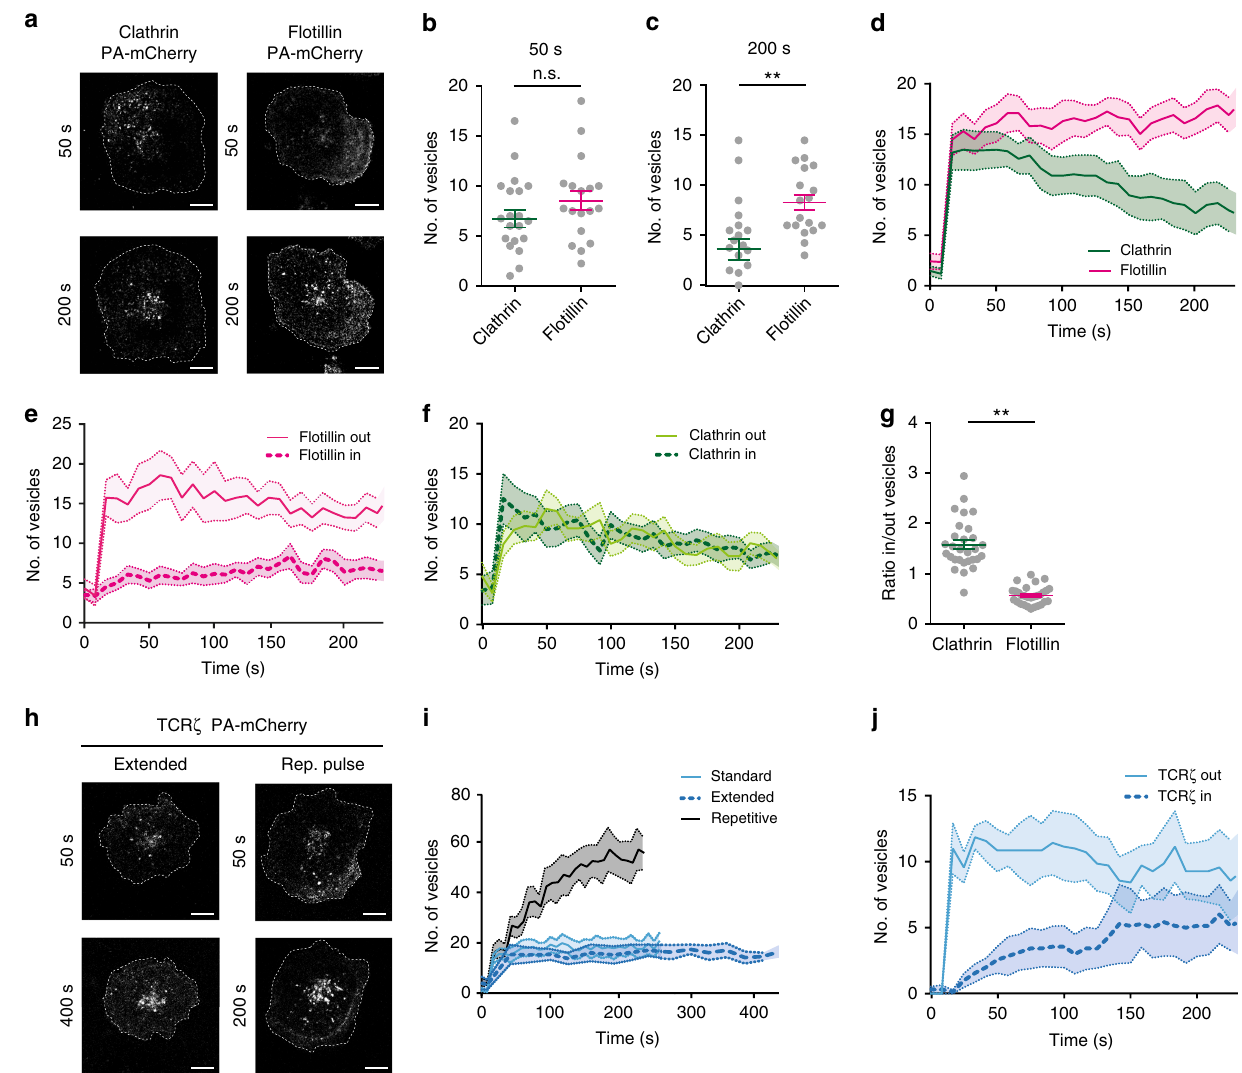
Fig. 3 Internalized fl otillins and TCR ζ de fi ne a long-lived mobile endocytic network. a Representative images of Jurkat T cells expressing Clathrin-PA- mCherry (left) or Flotillin-PA-mCherry (right), activated on anti-CD3 ε and anti-CD28-coated surfaces, photoactivated on a region of interest and subsequently imaged for 250 s. Images are from 50 and 200 s after photoactivation. Number of PA-mCherry vesicles detected in each frame at ( b ) 50 s and ( c ) 200 s. d Number of PA-mCherry vesicles detected at any given point during 250 s acquisition. e Number of PA-mCherry vesicles detected within or outside of the central endosomal region for each frame during the time of acquisition for Flotillin2-PA-mCherry and ( f ) Clathrin-PA-mCherry. g Ratio of Flotillin2-PA-mCherry or Clathrin-PA-mCherry positive vesicles detected in or out of the central endosomal region. h Example of Jurkat T cells expressing TCR ζ -PA-mCherry after photoactivation of a region of interest and imaged for 450 s (extended) or in cells repetitively photoactivated every 8 s (repetitive). i Number of PA-mCherry vesicles detected in each frame during the time of acquisition as in Fig. 1b (standard) or during extended and repetitive acquisition. j Number of TCR ζ -PA-mCherry vesicles detected within or outside of the central endosomal region for each frame during the time of acquisition. Each dot represents a cell. Scale bars, 5 µ m. Data obtained from three or more independent experiments. Small horizontal lines indicate mean (±SEM). ns, not signi fi cant; ** p < 0.001, Mann – Whitney t -test cross-channel nearest neighbor distance between vesicles in the transferrin, labelled with Alexa488, signi fi cantly more than they green channel (clathrin-EGFP) and vesicles identi fi ed in the red did with randomly distributed vesicles (41.7%, Fig. 2c). channel (TCR ζ -PA-mCherry). Taking into account the average size of vesicles and the resolution of confocal microscopy, a vesicle in the fi rst channel was considered to be the same vesicle as that in the second channel if its nearest neighbor in the second channel was within 320 nm. In accordance with the results obtained with pitstop2, endocytic vesicles de fi ned by TCR ζ -PA- mCherry did not coincide with vesicles de fi ned by clathrin-EGFP more than with vesicles randomly distributed throughout the cell (11%, Fig. 2c). Importantly, vesicles de fi ned by clathrin-EGFP did overlap in space and time with the canonical clathrin cargo | DOI: 10.1038/s41467-018-04088-w |